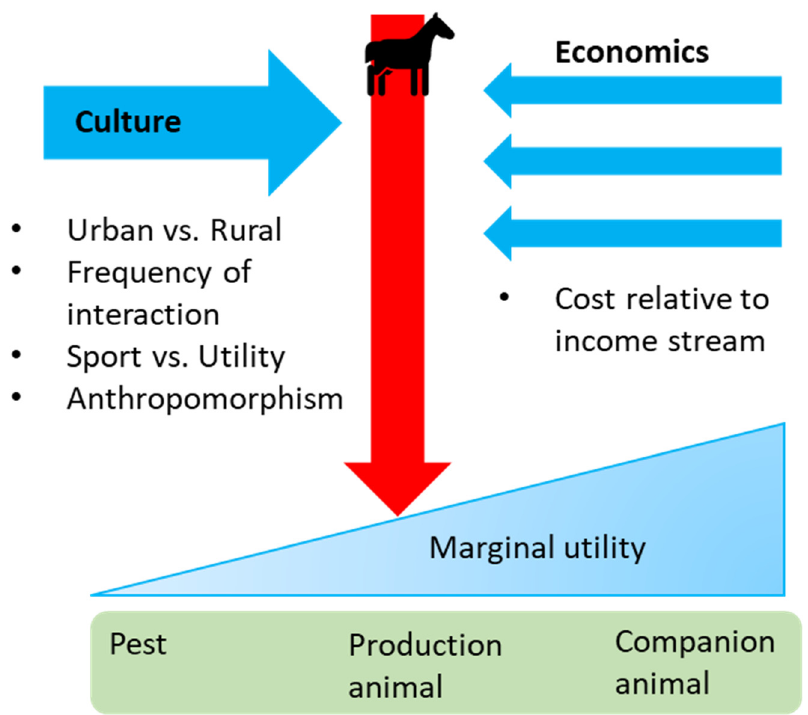
Figure 2. Conceptual schema of a sliding scale of marginal utility (worth) of the horse. Where the horse sits on the scale may be influenced by various perspectives from different aspects of society, which in turn alters the social licence of the use of the horse in the racing industry.